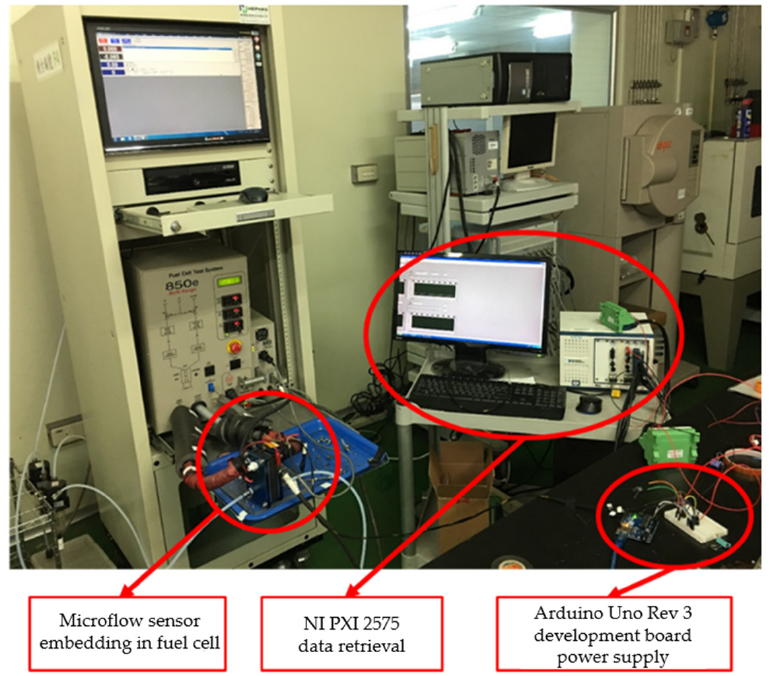
Figure 6. Calibration system diagram of the microflow sensor.